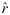
The repulsive expansion model captures colony growth dynamics.A. Illustration of the repulsive expansion dynamics. Each orange dot represents a cell at that given location. As cells in the colony grow and divide, cells in the interior will push the outer cells, generating a velocity field u(x,t). Given a location, r^ is the normal vector along radial direction. Therefore u∙r^ represents the radial expansion velocity at the location. Since the model is assumed to be radial symmetric, the most outer layer of cells determines the size of the colony. At time t, the colony radius is expressed as R(t). The different color lines indicate different cell trajectories. Colors are chosen simply for distinguishable visualization effect. B. Colony growth over time. The black line indicates the radius of the colony, the colored lines represent the trajectories of pre-selected 10 locations within the colony. C. Sample trajectories of individual cells in the ABM simulation. Each trajectory shows the movement of a single cell. Here, cells are approximately spherical; time is measured in generations (~30 minutes). D. Average trajectories of cells in the ABM simulation over time. Cells were assigned to 5 different groups according to their radial positions when the total population of the colony reached 1000 cells; subsequently, all the 1000 cells were tracked over time in terms of their radial positions. Each of the colored lines shows the average trajectory of the cells in each group.